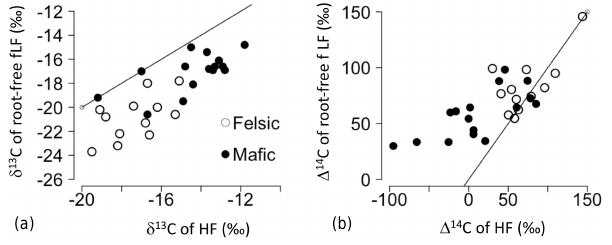
Figure 2. Comparison of 13 C (a) and 14 C (b) in root-free free light fraction (root-free fLF) and heavy fraction (HF) organic C for individual samples from A horizons (see Table 3). Felsic litholo- gies (white circles) include soils developed on granite and rhyolite; mafic lithologies (black circles) include soils developed on gabbros, basalts, and nephelinite. The 1:1 correlation line is plotted for ref-